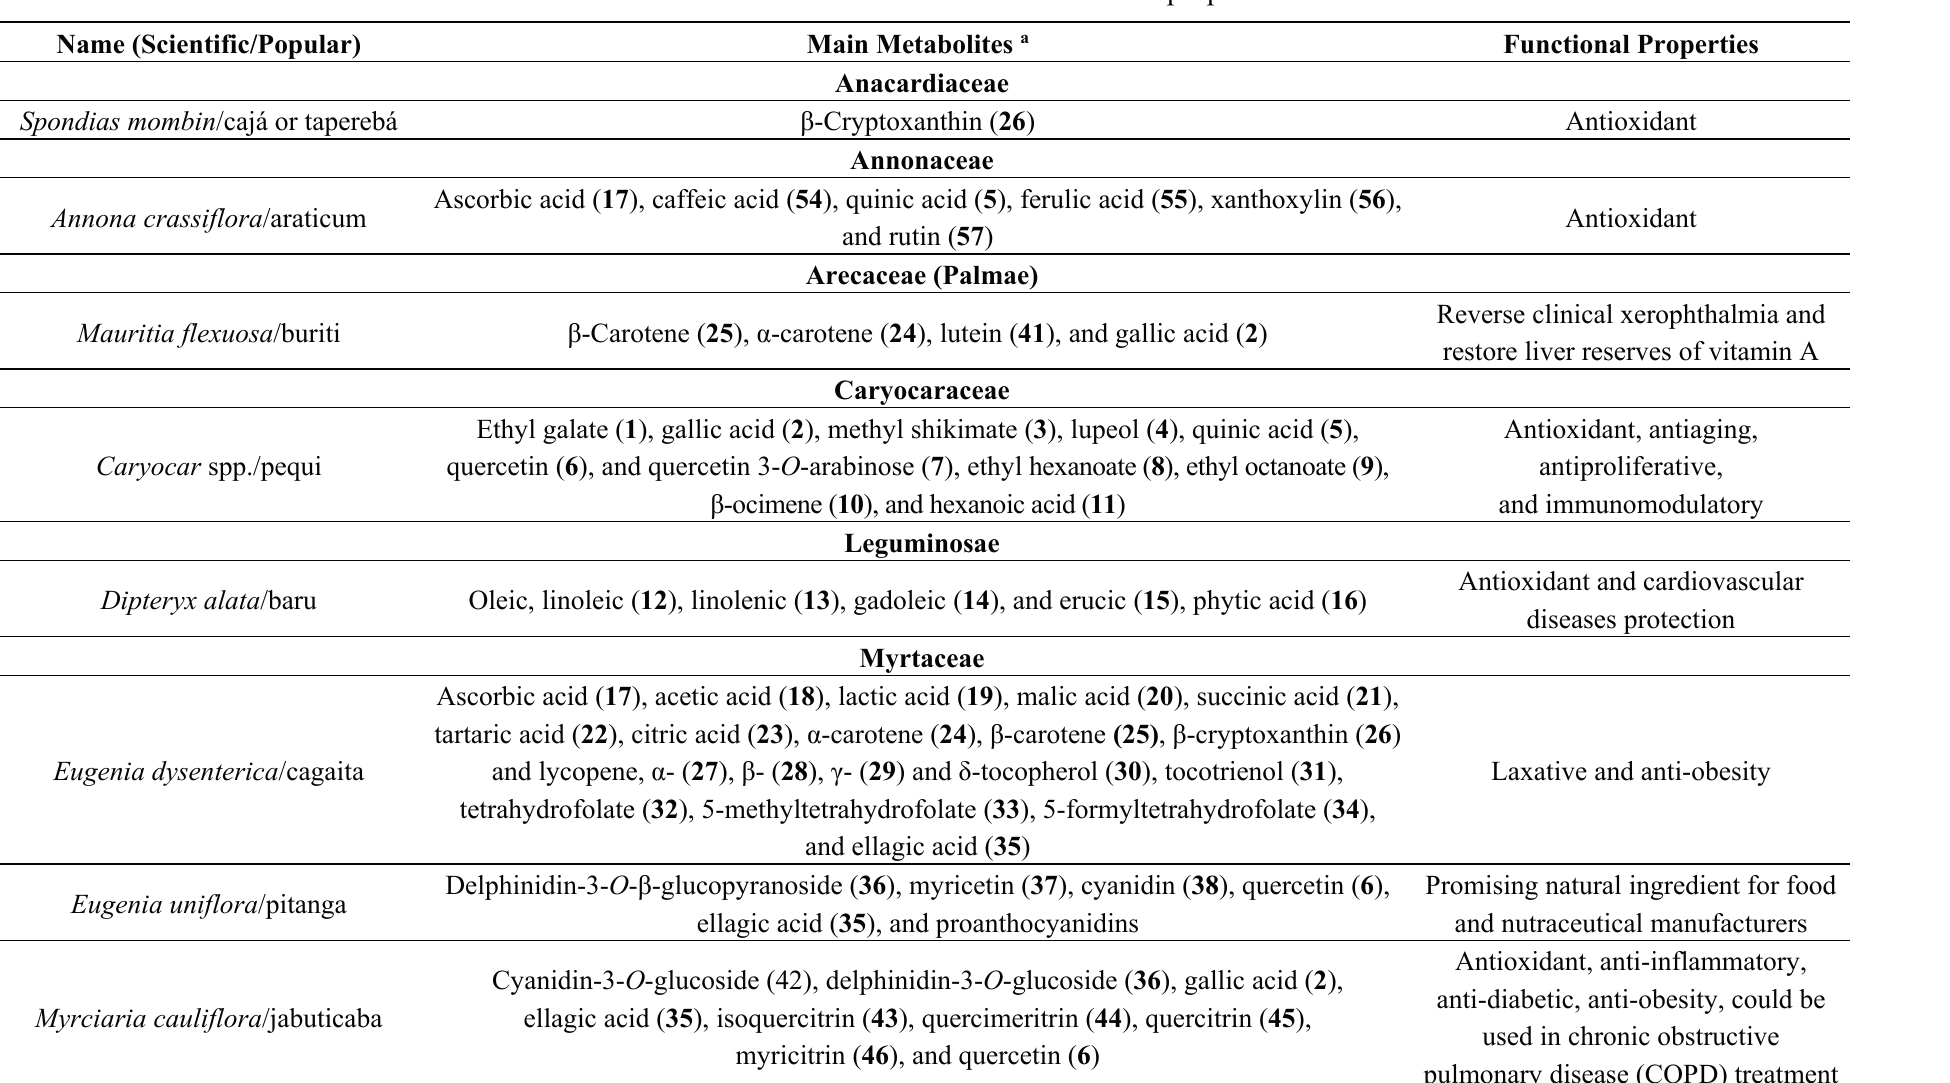
Table 1. Cerrado fruits with main metabolites and functional properties